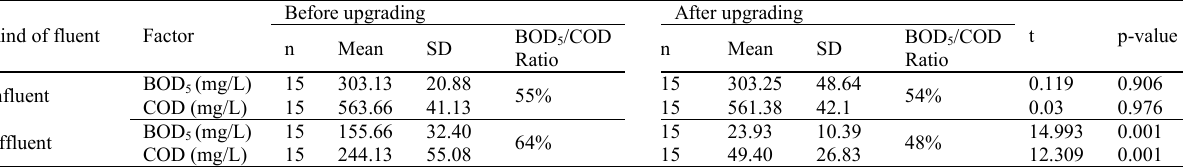
Table 2. Results of paired T-test analysis used for assessment of influent wastewater to TMWTP before and after upgrading